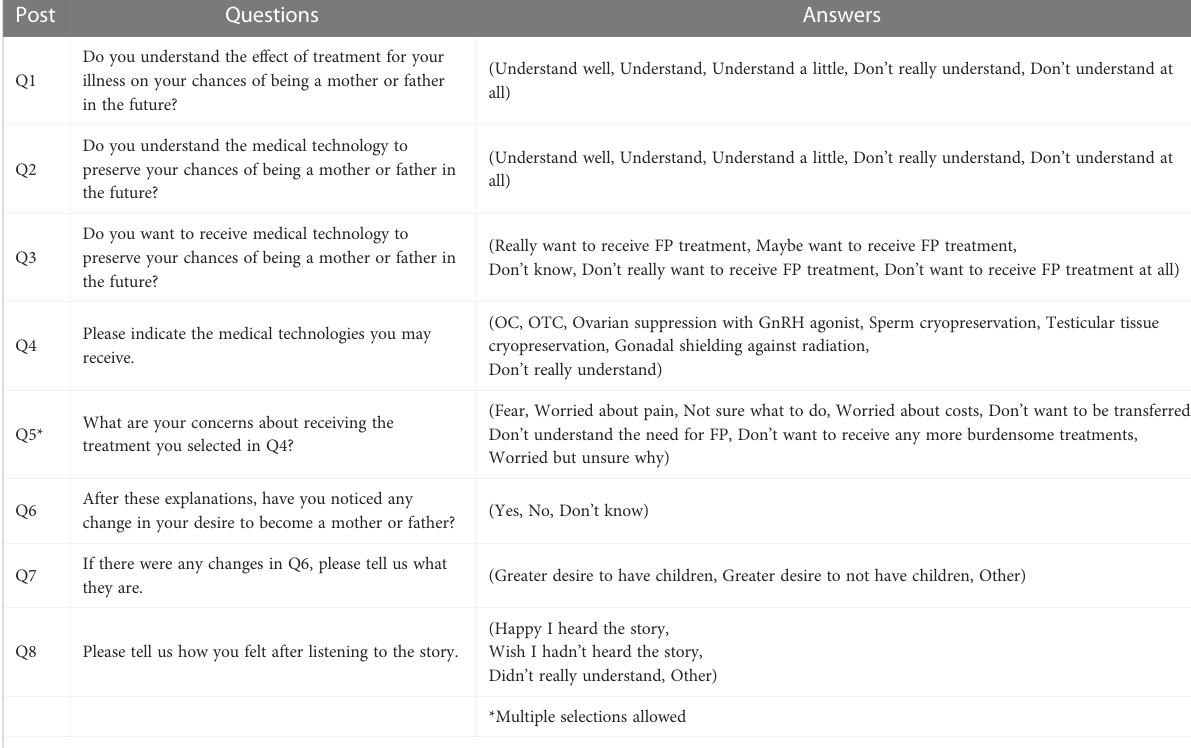
TABLE 2 Questionnaire post-explanation of fertility preservation. Post